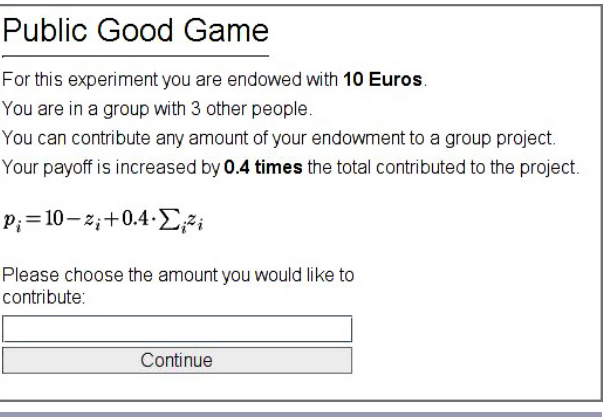
Fig. 4 . A screenshot of the BoXS experimental